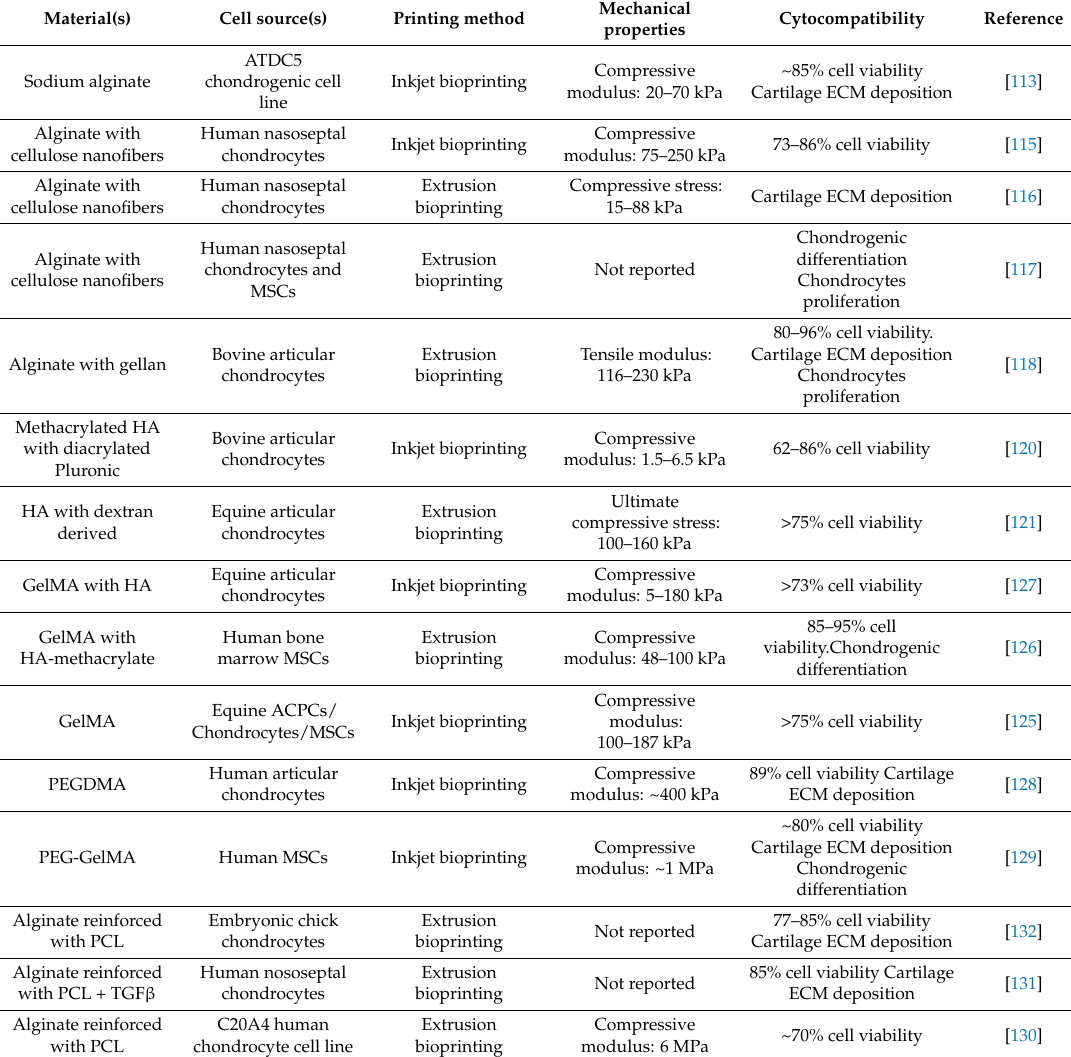
Table 2. Overview of publications on 3D printing of hydrogels for cartilage tissue